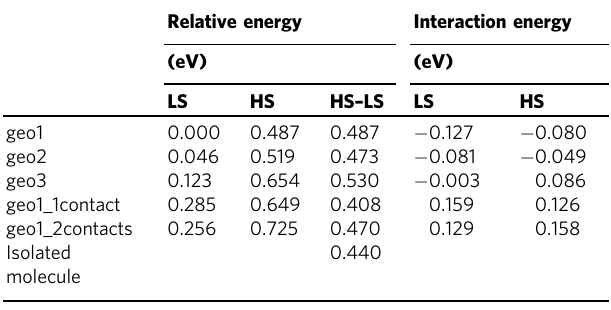
Table 1 SCO energy parameters for different